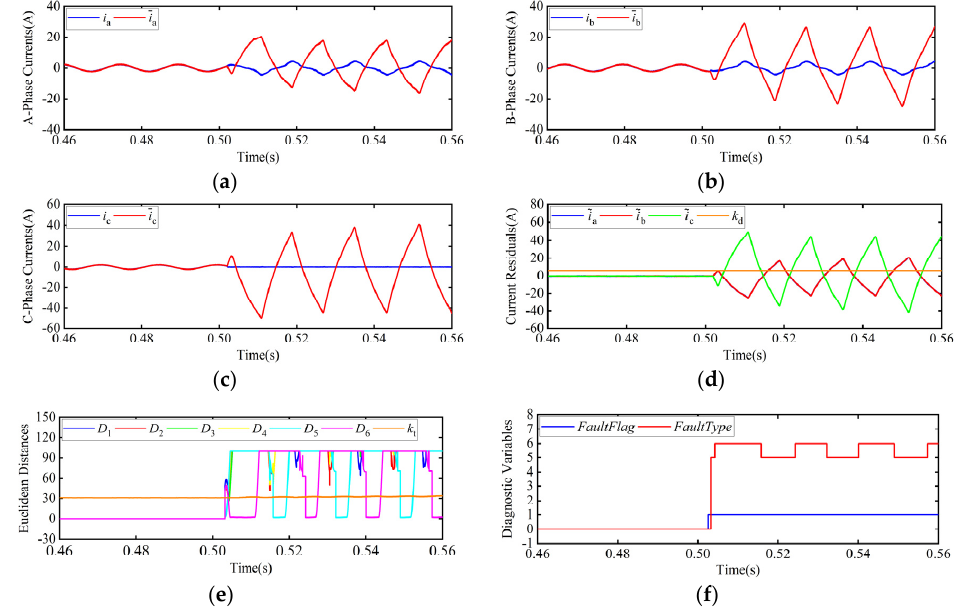
Figure 5. Diagnosis for the OC fault of T 5 and T 6 under 2 N·m load and for a reference speed of 1000 r / min: ( a ) A-phase currents; ( b ) B-phase currents; ( c ) C-phase currents; ( d ) current residuals; ( e ) Euclidean distances; ( f ) diagnostic variables.